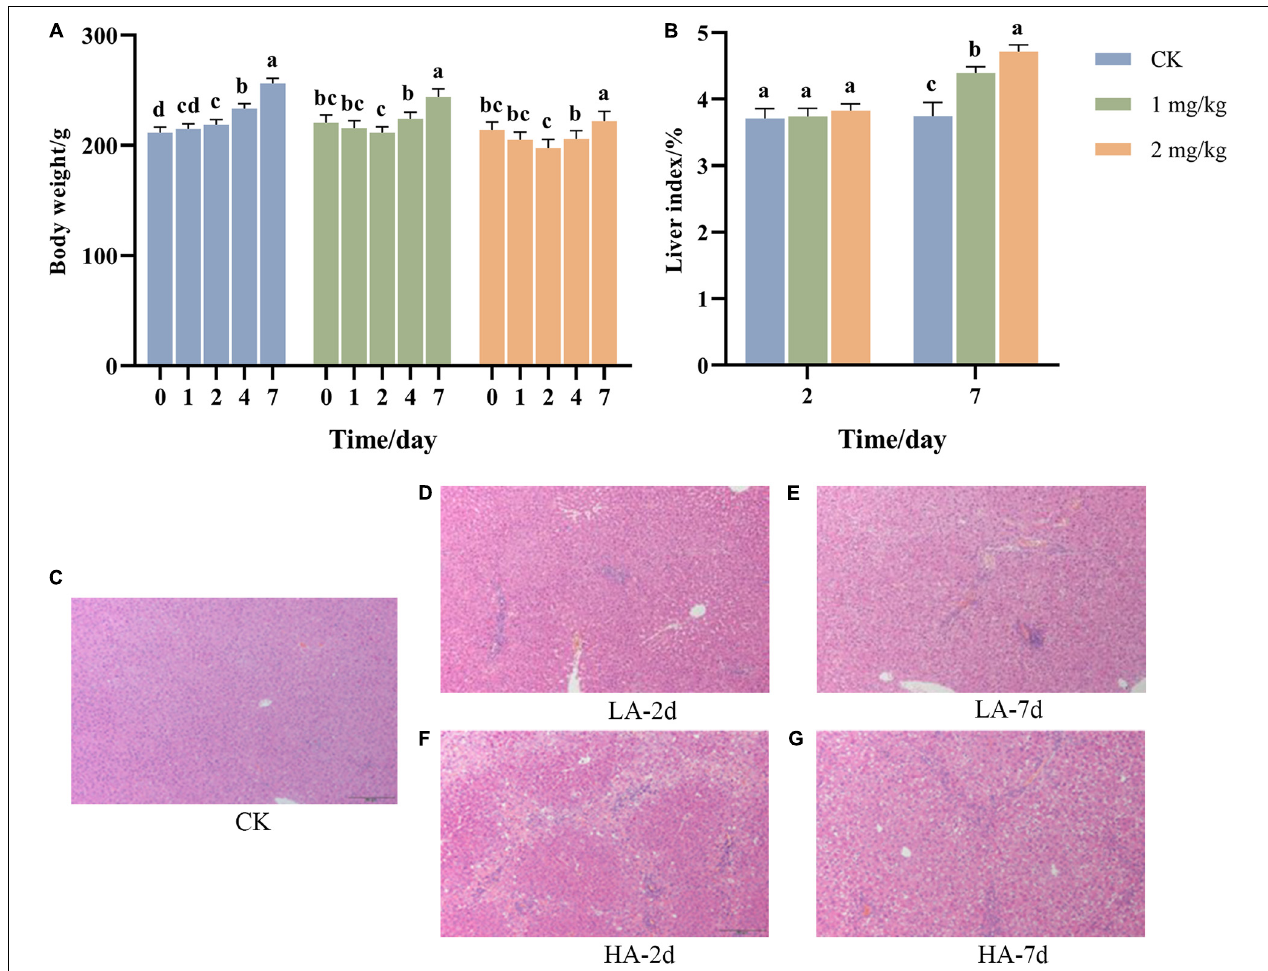
FIGURE 1 | Changes of (A) body weight, (B) liver index, and (C–G) liver pathological morphology with time after ASAE in rats (HE, × 100). 0: weight before ASAE; 1 and 4: weight on 1st and 4thr days after ASAE; 2 and 7: weight and index on 2nd and 7th days after ASAE. LA-2d and HA-2d: rats were sacrificed on the 2nd day after ASAE. LA-7d and HA-7d: rats were sacrificed on the 7th day after ASAE. The data are expressed as mean ± standard deviation. Different letters representing significant difference ( p < 0.05) (the same below).